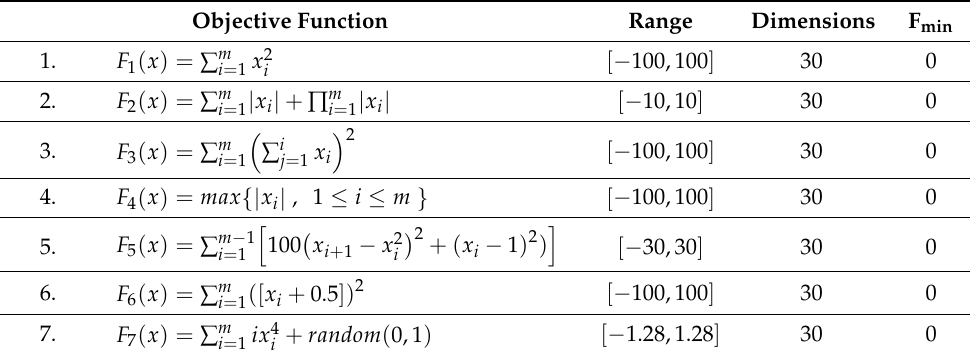
Table A1. Unimodal test